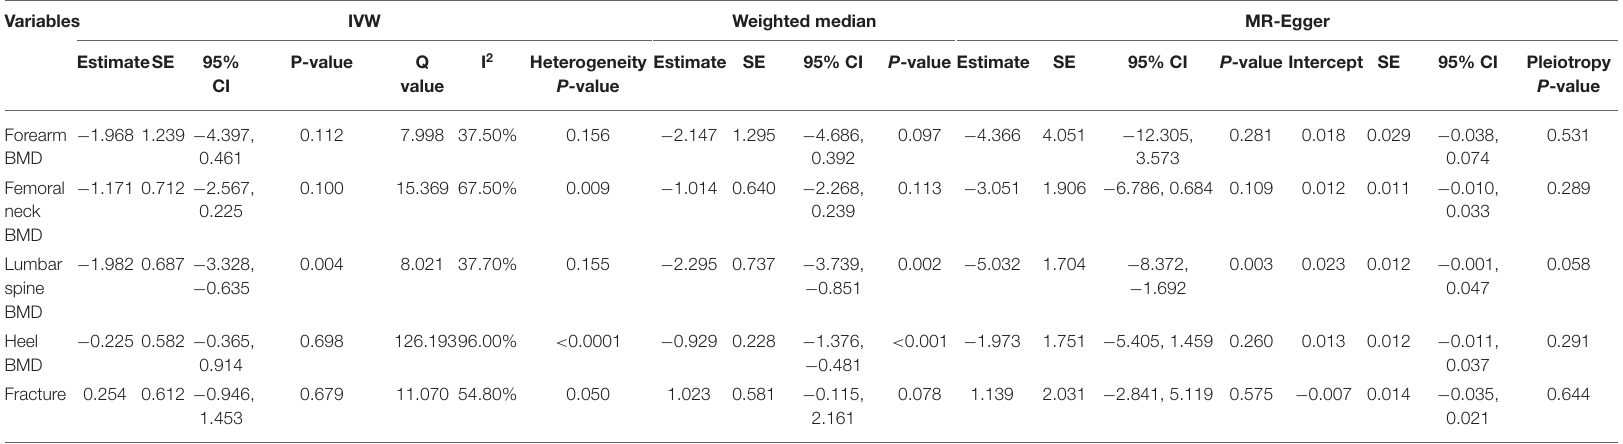
TABLE 2 | Mendelian randomization estimates of serum magnesium on osteoporosis.